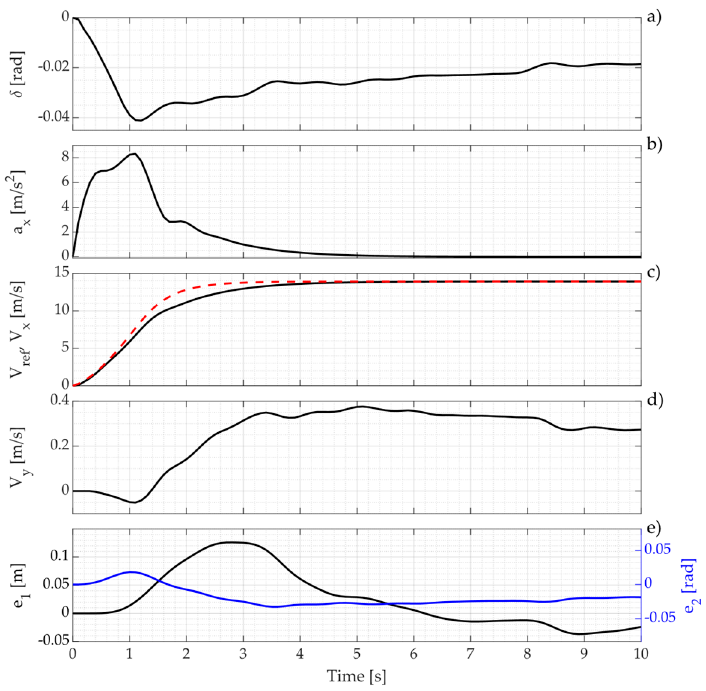
Figure 13. Results obtained during the right turn maneuver in MIL configuration (see Figure 10). Measured vehicle states: ( a ) Front wheels steering angle δ ; ( b ) Longitudinal acceleration a x ; ( c ) Longitudinal speed reference V ref (red, dashed) vs. Actual longitudinal speed V x (black, solid); ( d ) Lateral speed V y ; ( e ) Cross track e 1 (black, solid) and Relative yaw angle e 2 (blue,